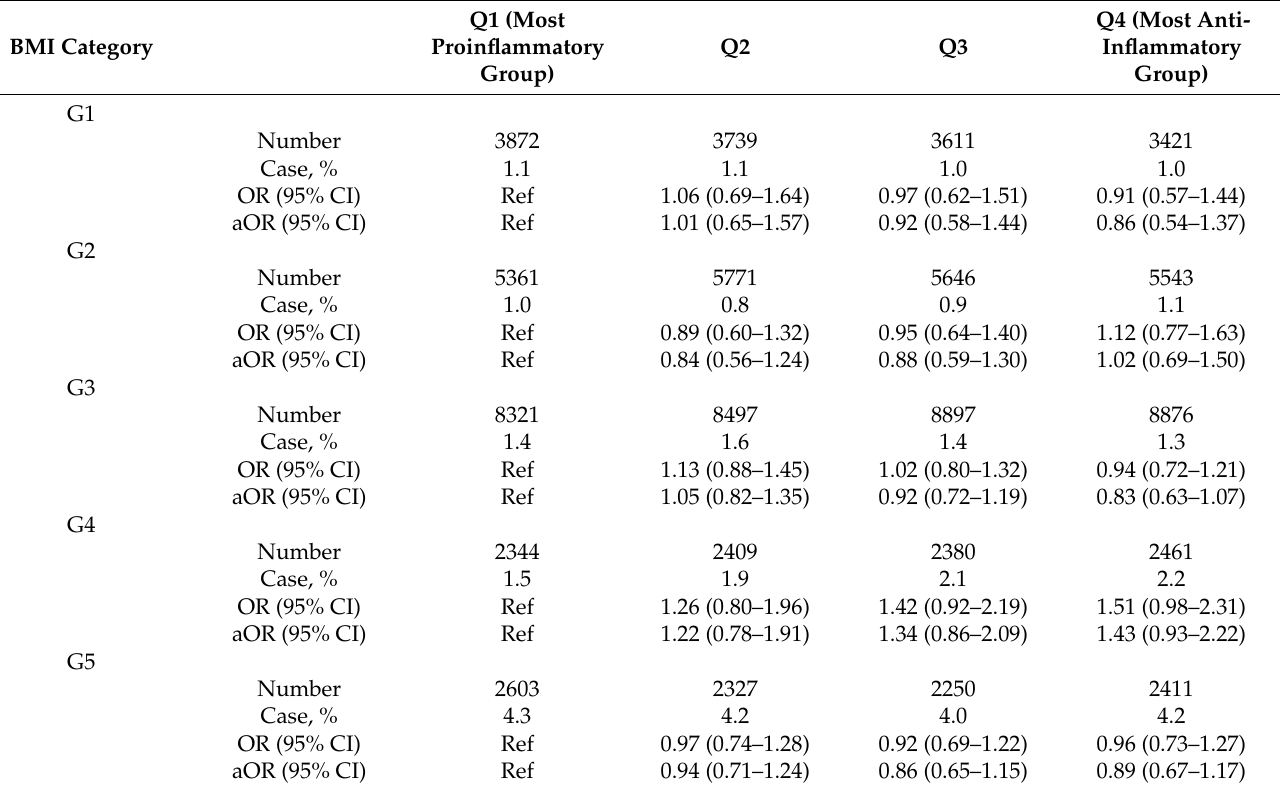
Table 5. Relationship between the dietary inflammatory index and the risk of late diagnosis gesta- tional diabetes mellitus